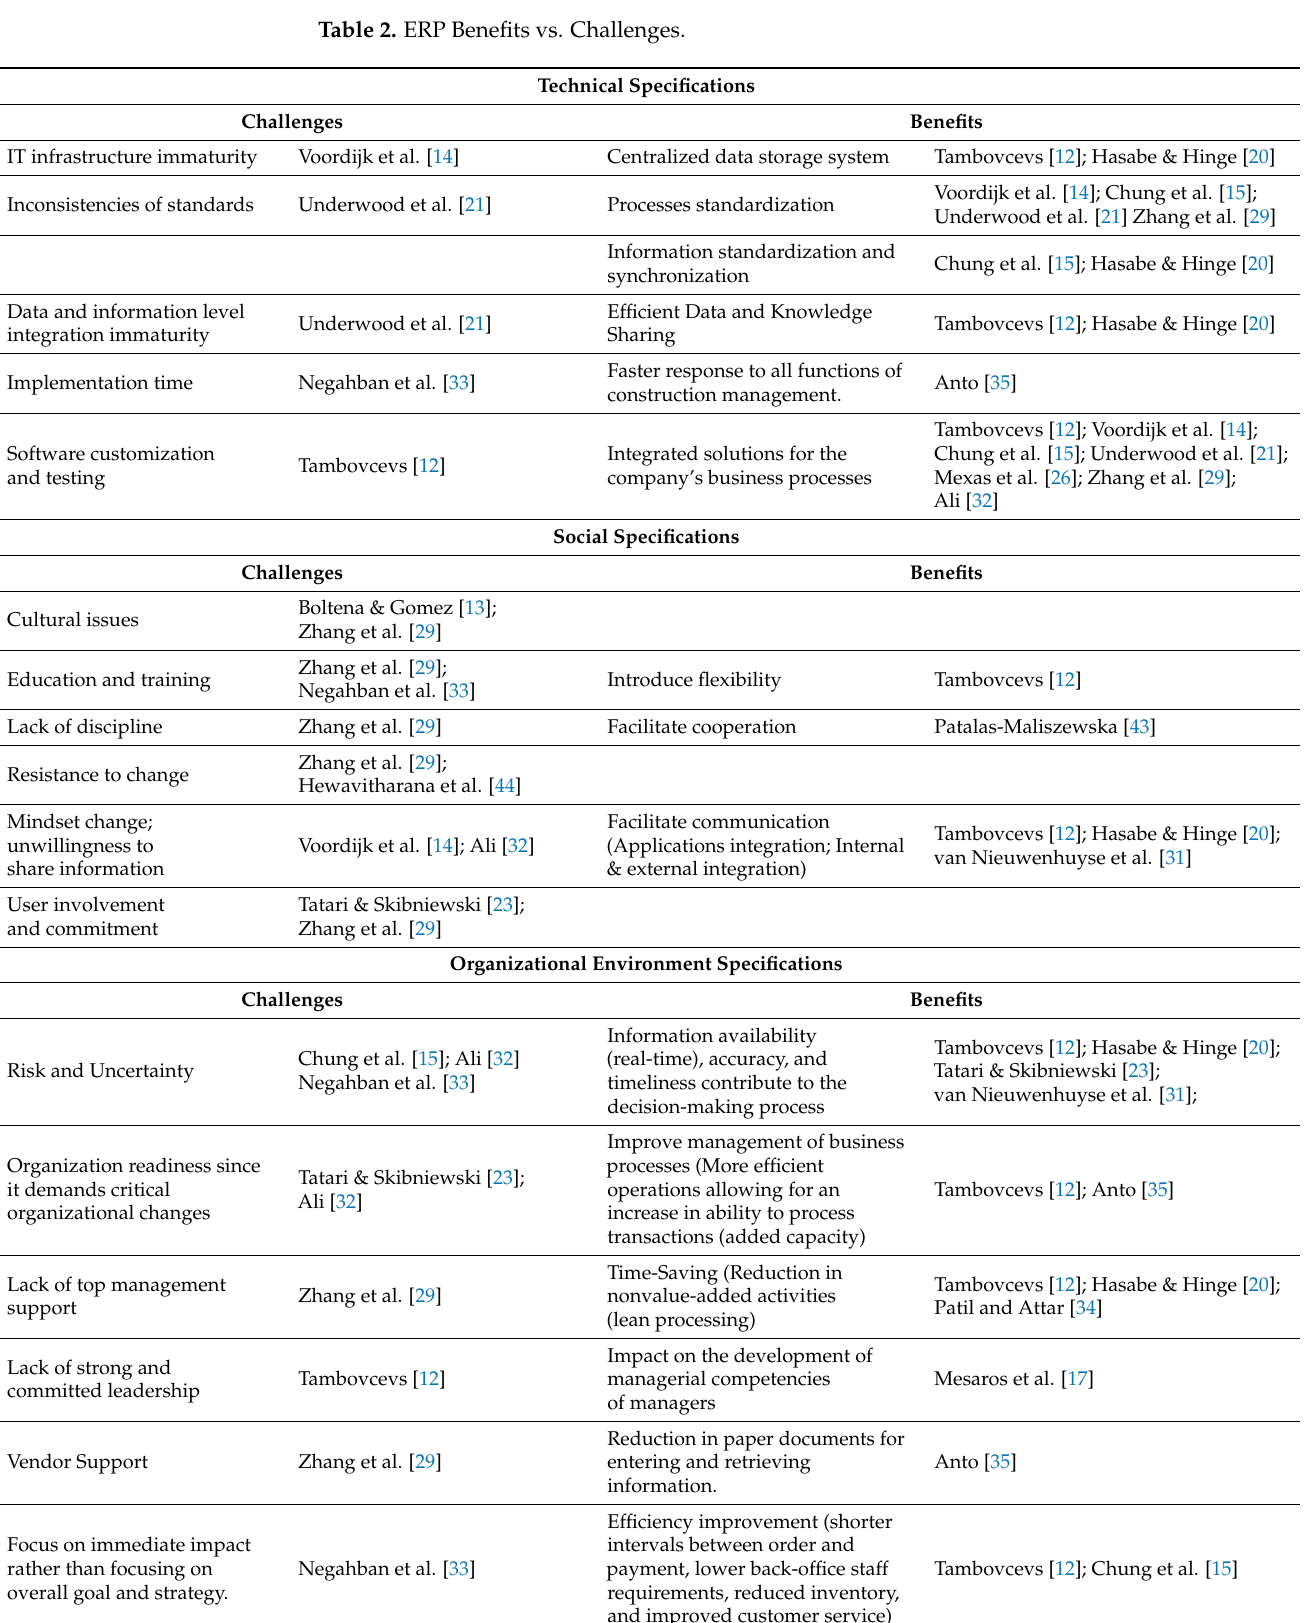
Table 2. ERP Benefits vs.